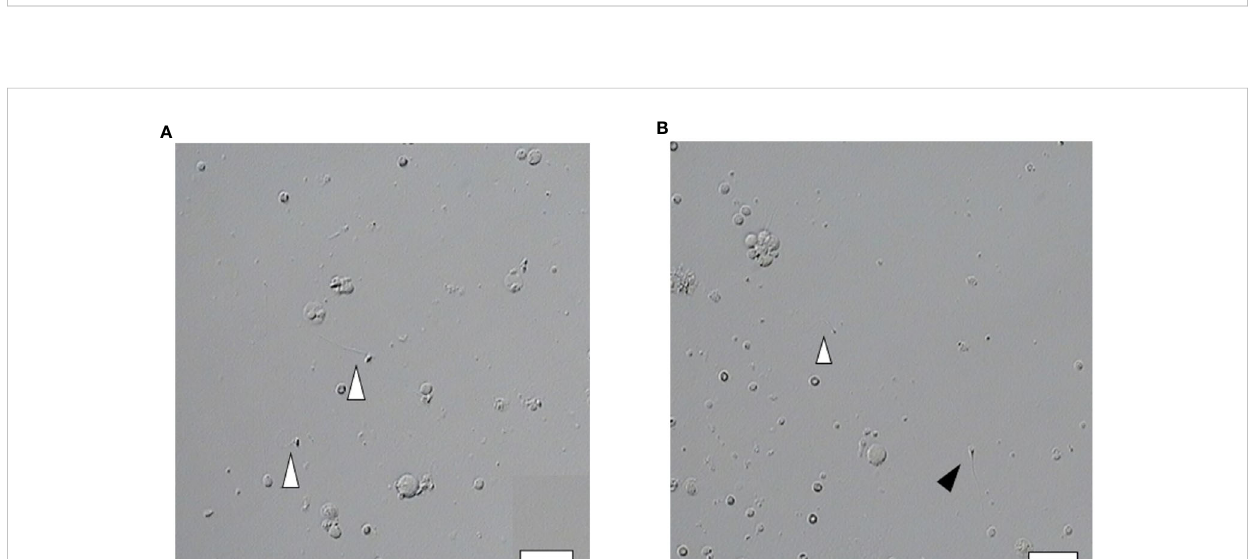
FIGURE 1 Schematic overview of the study.